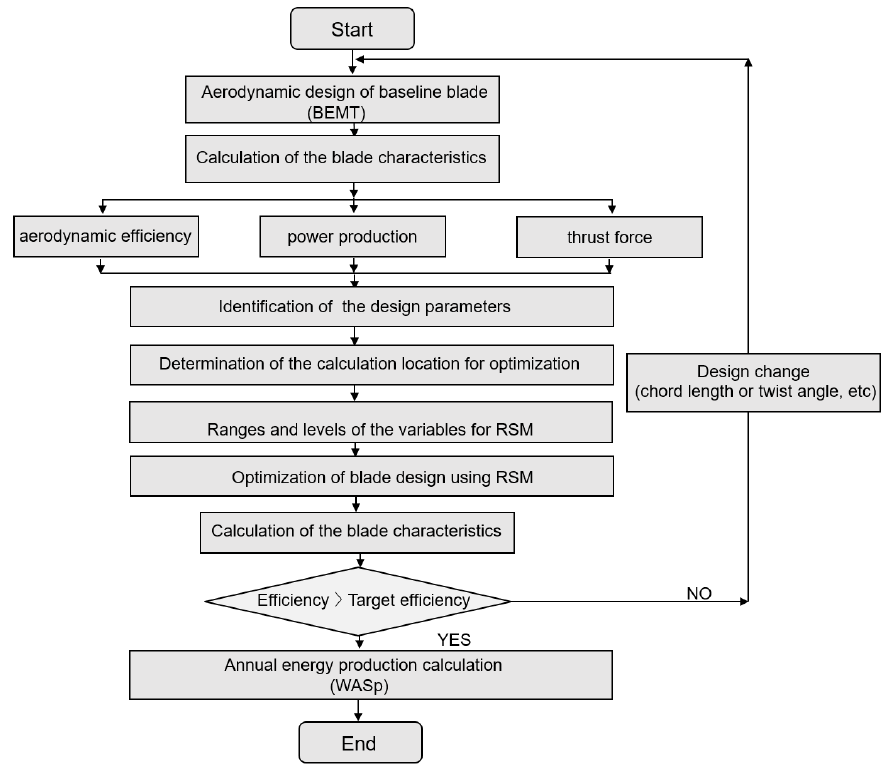
Figure 2. Schematic diagram of the present blade design optimization procedure.